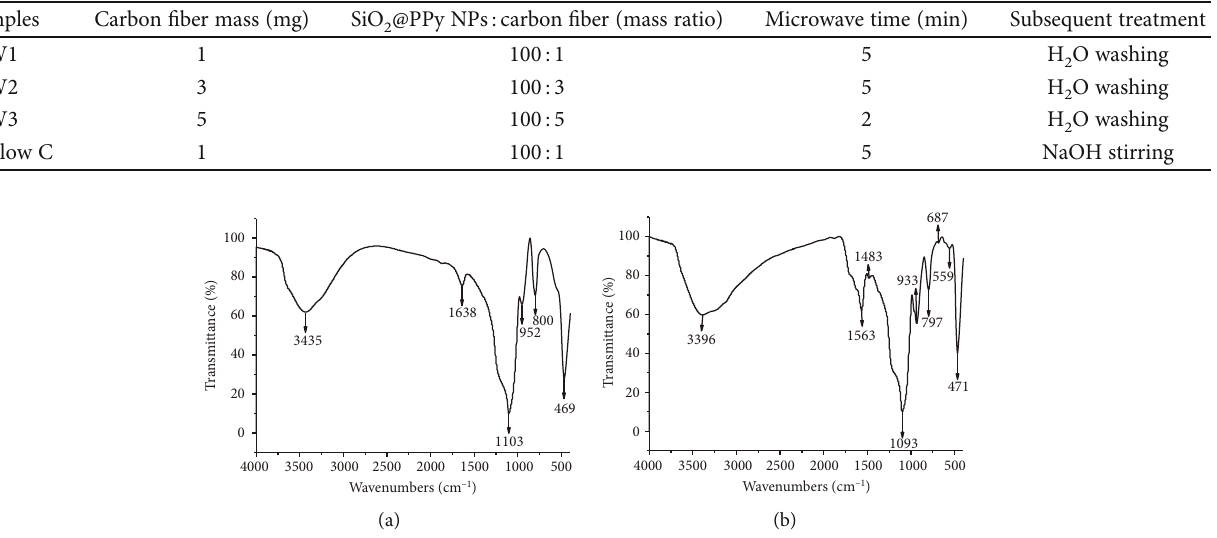
NPs and (b) SiO 2